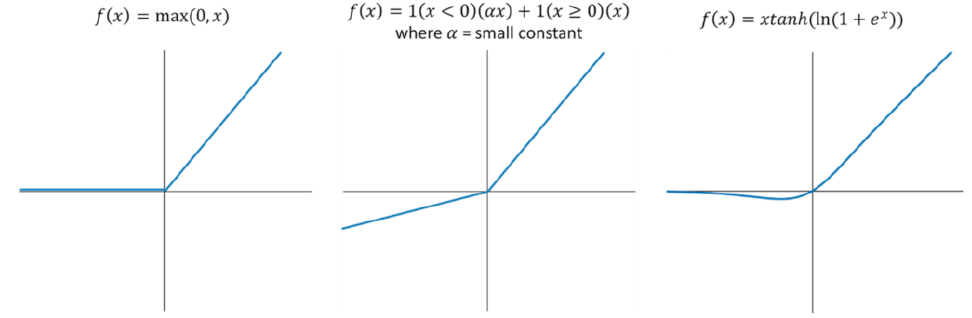
Figure 6. Activation Functions. ( Left ) Rectified Linear Unit (ReLU); ( Center ) Leaky ReLU; ( Right )